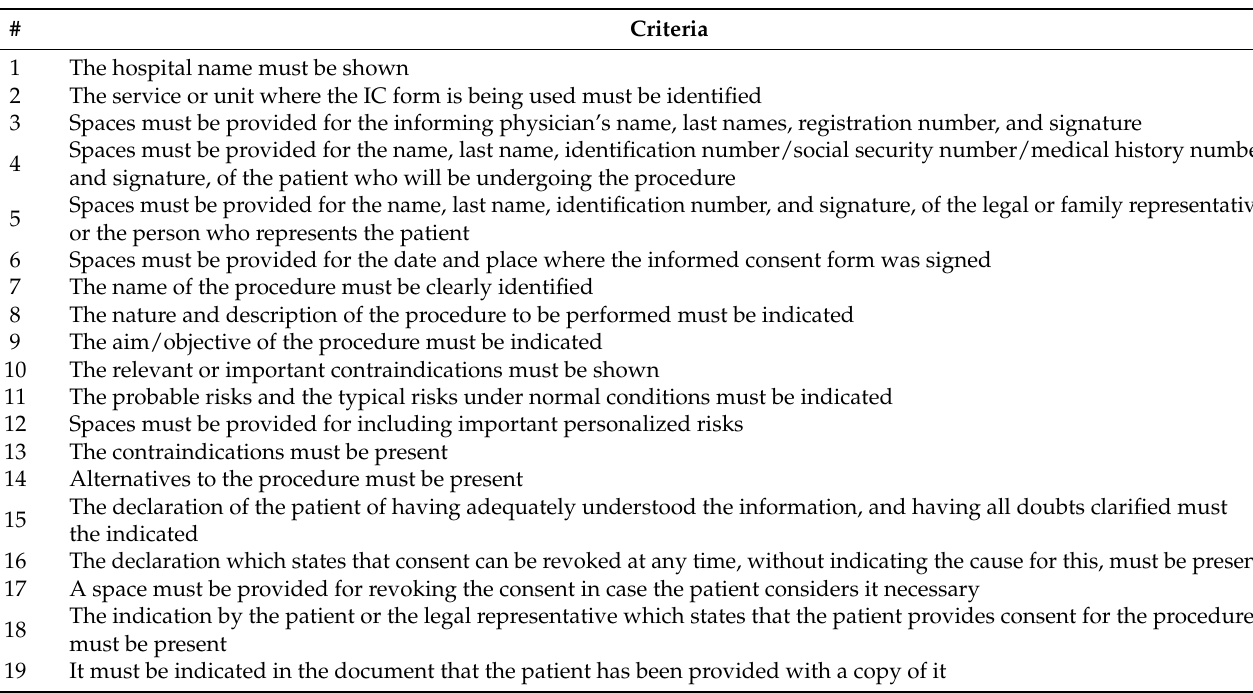
Table 1. Formal quality criteria of the informed consent form.